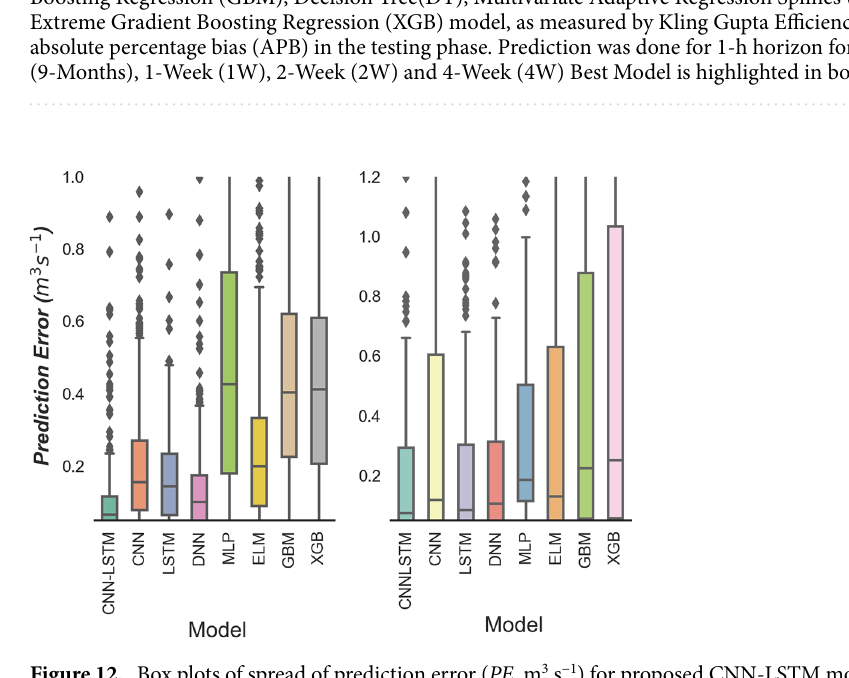
Figure 12. Box plots of spread of prediction error ( PE , m 3 s −1 ) for proposed CNN-LSTM model during test period compared with standalone model Convolutional Neural Network (CNN) and Long Short Term Memory Network (LSTM) as well as the Deep Neural Network (DNN), Multi-Layer Perceptron (MLP), Extreme Learning Machine (ELM), Gradient Boosting Regression (GBM) and Extreme Gradient Boosting Regression (XGB)